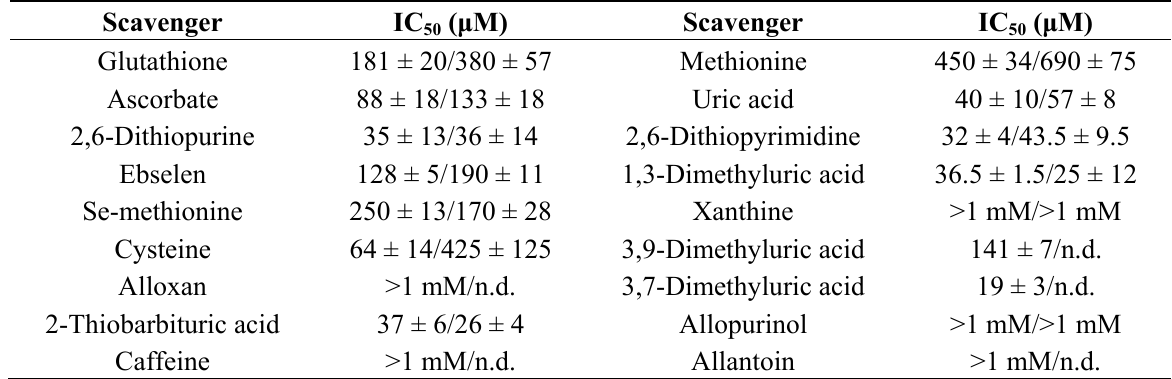
Table 1. Half-maximal inhibition concentrations (IC the nitration (pH 6) and nitrosation (pH 9) of phenol by peroxynitrite